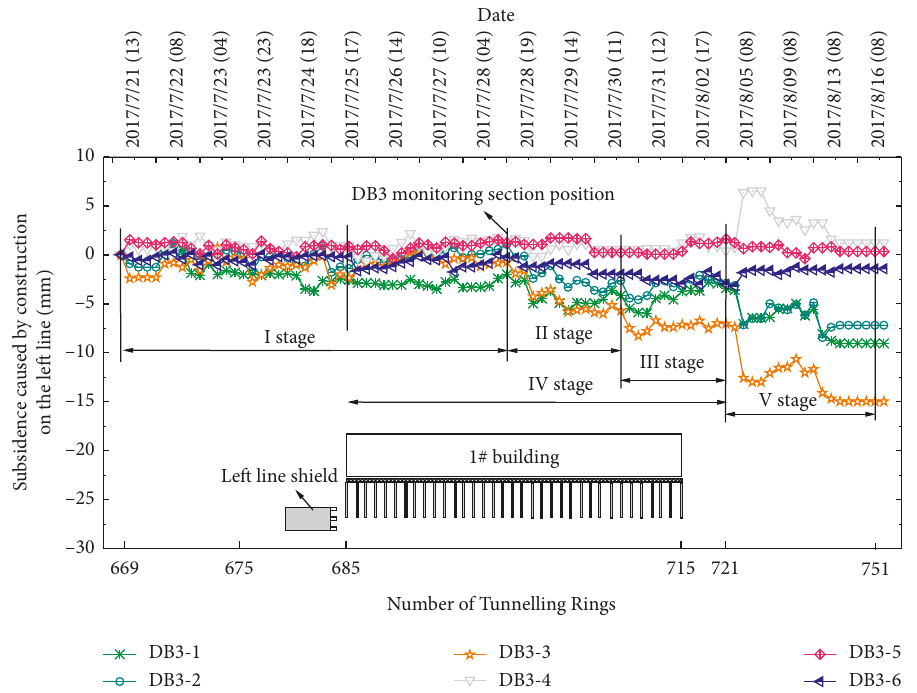
Figure 10: Monitoring time-history curve of surface subsidence of section 3.